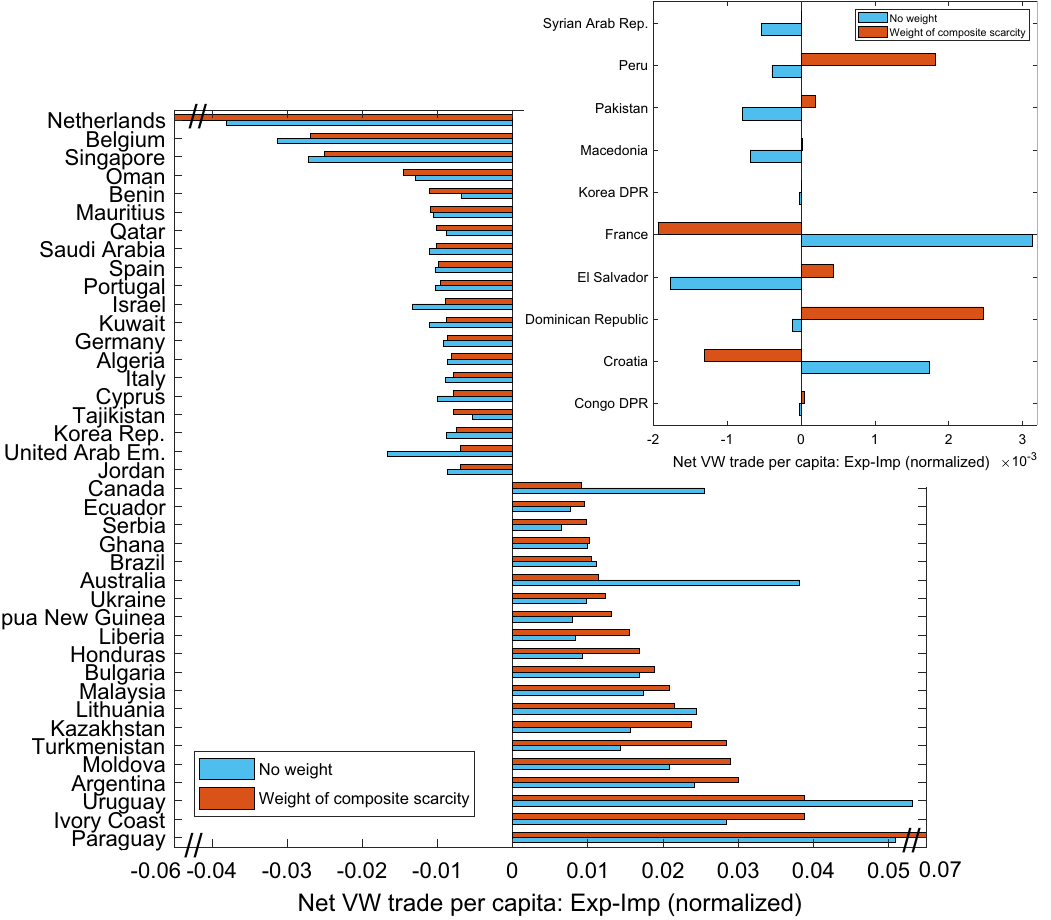
Figure 5. Largest 20 net CWSI-weighted VW per capita exporters (positive values for sn and swn ) and largest 20 net CWSI-weighted VW per capita importers (negative values for sn and swn ), expressed as world share. Net